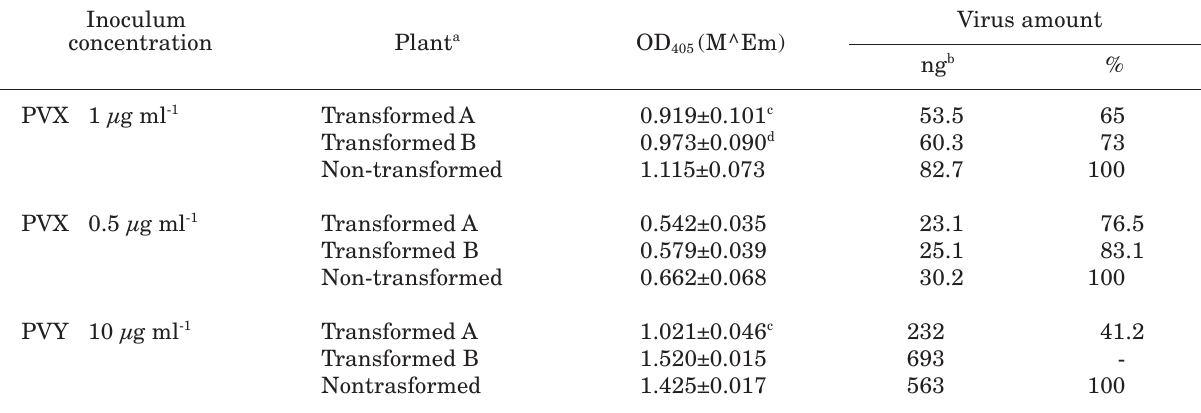
Table 1. Virus content of two clones of potato plants transformed with the pac 1 gene (A and B) and one non-trans- formed clone 40 days after inoculation with three concentrations of PVX and PVY suspensions, as determined by ELISA